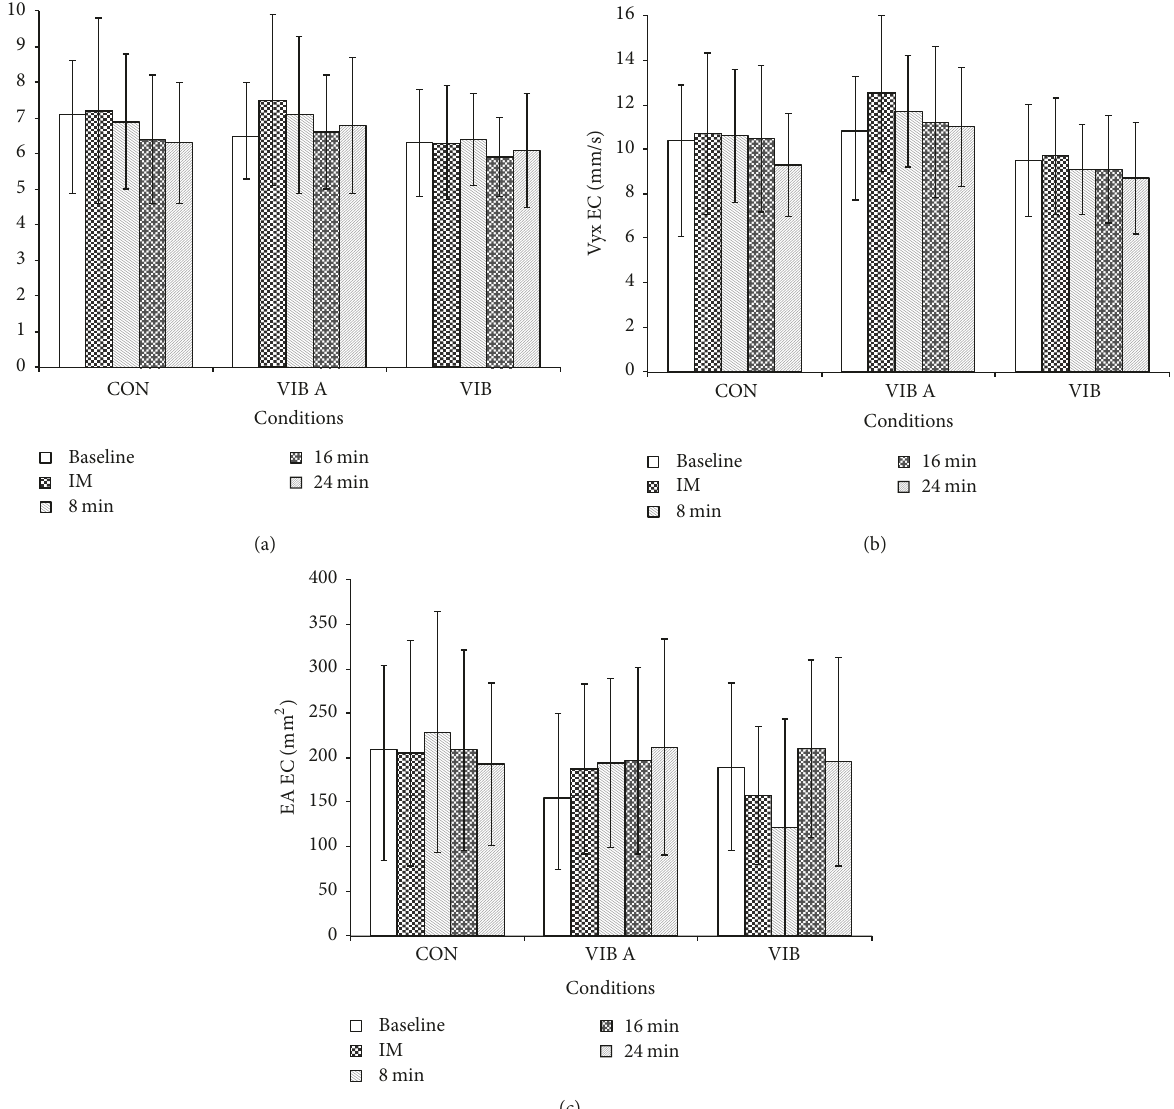
Figure 2: Mean values at baseline, immediately (IM) after the vibratory stimulus, and 8, 16, and 24 minutes after the vibratory stimulus. Mean velocity measures in the (a) medial-lateral direction (VMx; mm/s); (b) anterior-posterior direction (VMy; mm/s); and (c) elliptical area (EA; mm 2 ), during eyes closed (EC)